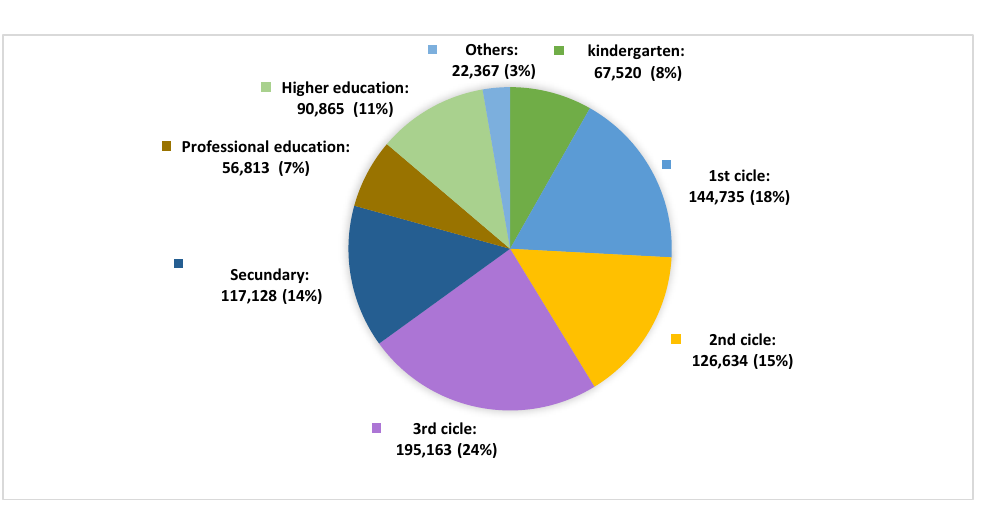
Figure 2. District implementation rate: schools enrolled vs. total schools. Source: (ABAE 2021, 2022a).